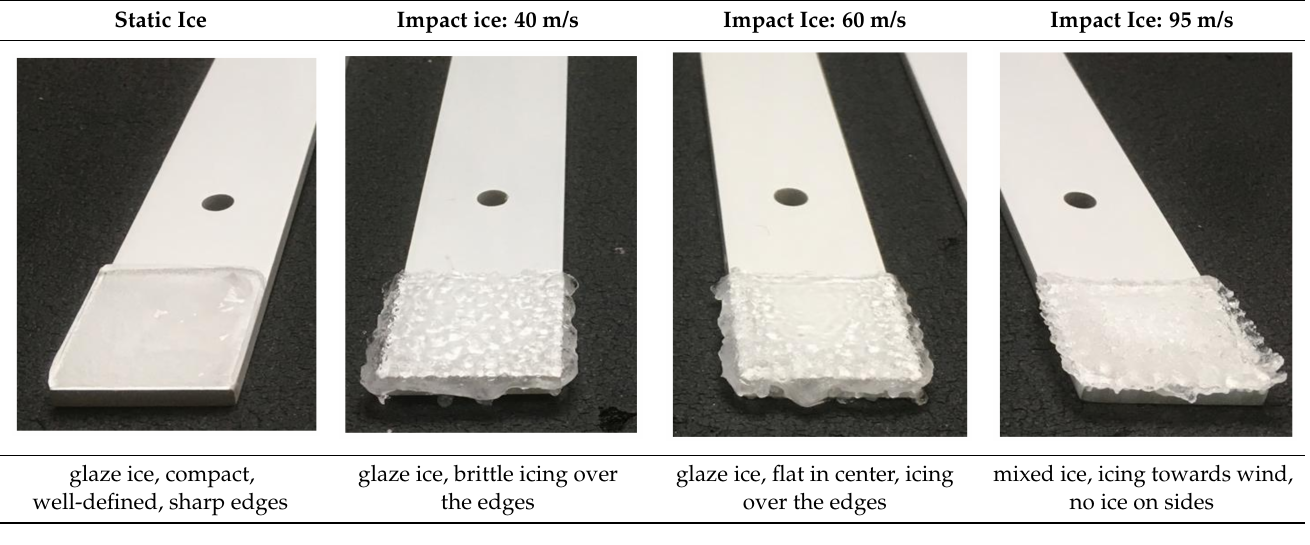
Table 4. Ice types for ice adhesion tests.